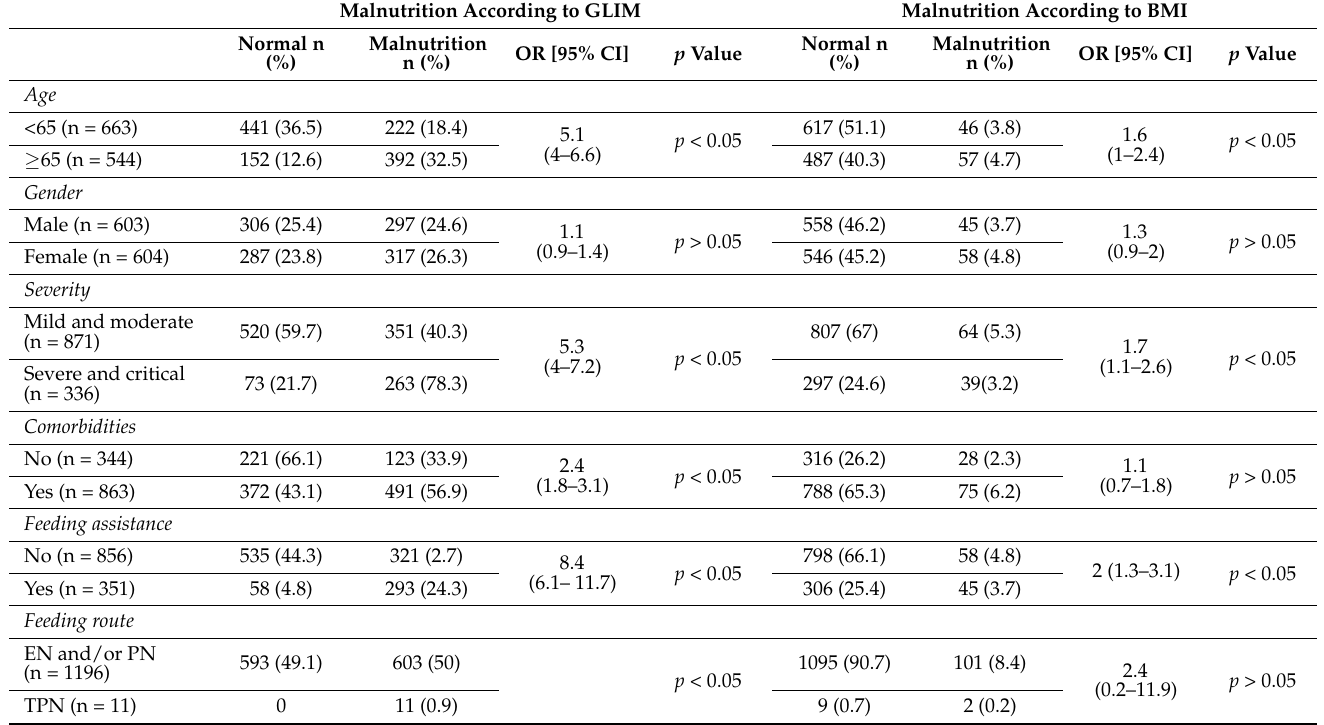
Table 3. Association between nutritional status and age, gender, severity, comorbidities, feeding assistance and feeding